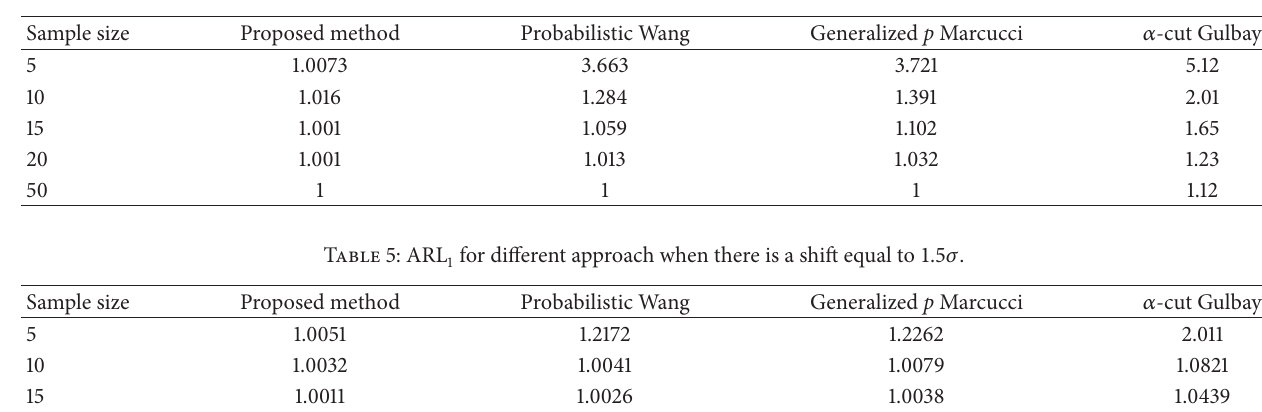
Table 4: ARL for different approach when there is a shift equal to 1𝜎 . 1